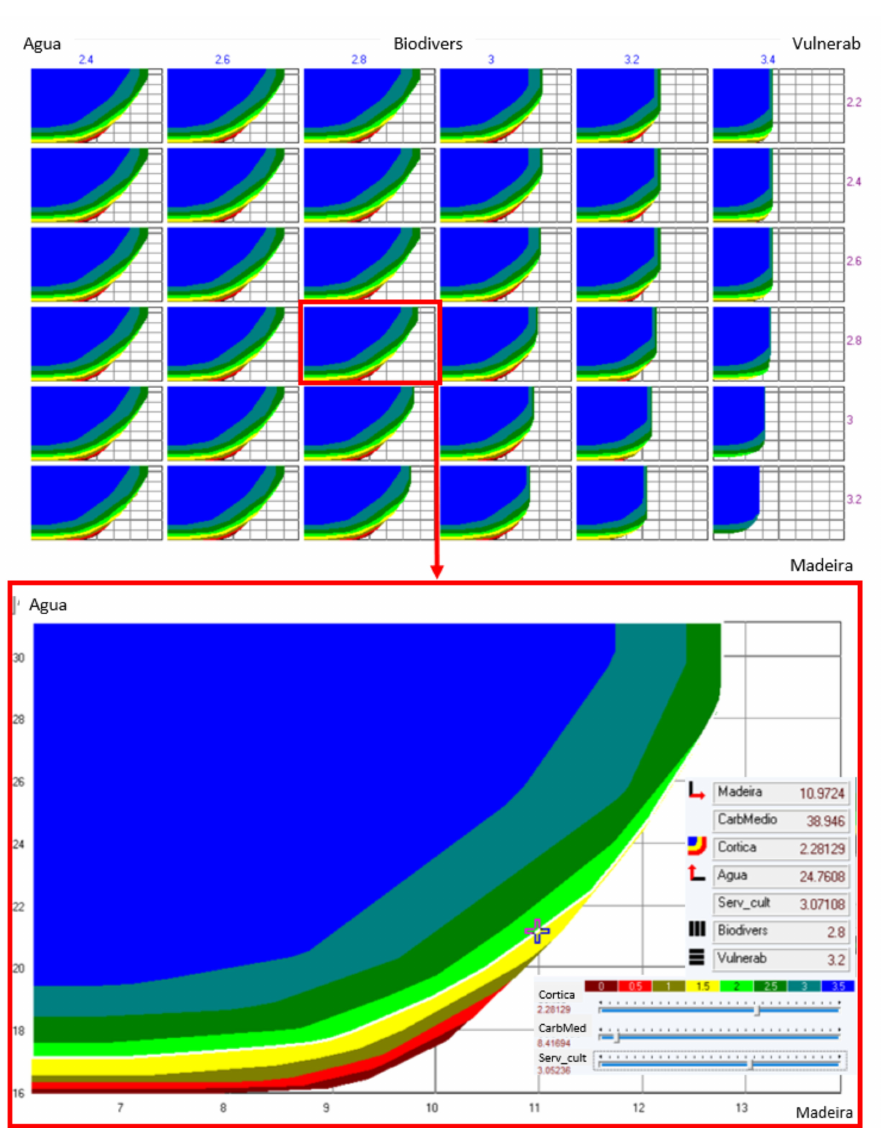
Figure 3. Example of group solution considering the trade-offs for seven ecosystem services using the multicriteria Pareto frontier method. Madeira (wood) refers to the total amount of harvested wood in the case study area in the planning horizon (*10 6 m 3 ), represented in the X axis; Agua (soil erosion) is the total soil loss caused by the rainfall (*10 5 t) (in Y axis). Each of the eight decision maps (in colors) represents Cortica (cork), being the amount of removed cork (*10 5 arroba; arroba = 14.7 kg); Biodivers (biodiversity) is the average biodiversity level represented in columns; Vulnerab (vulnerability) represents the average wildfire resistance represented in rows. In the scroll bars are represented the sixth and seventh ecosystem service (CarbMedio and Serv_Cult), where CarbMedio (average carbon) represents the average carbon stock for the whole landscape (*10 5 t), and Serv_Cult (cultural services) represents the leisure and recreation computed thru RAFL index. The plus sign represents a selected point in the